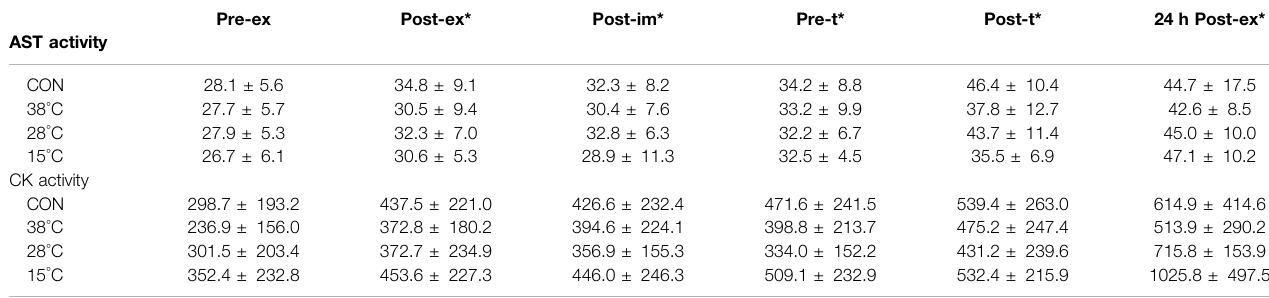
TABLE 2 | Effect of post exercise recovery by water immersion on muscular damage markers.